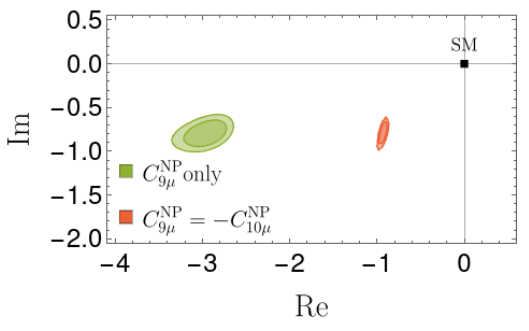
Figure 8 . Constraints in the complex plane on C 9 µ , assuming C 9 µ only and C 9 µ = − C 10 µ for the uncertainties as specified by (3.9) and